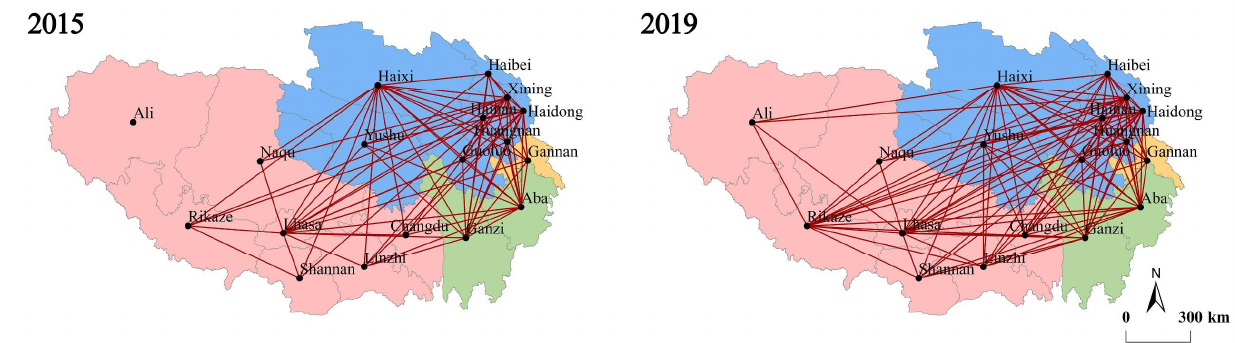
Figure 4. Tourism economic network structure of the Tibetan Plateau.